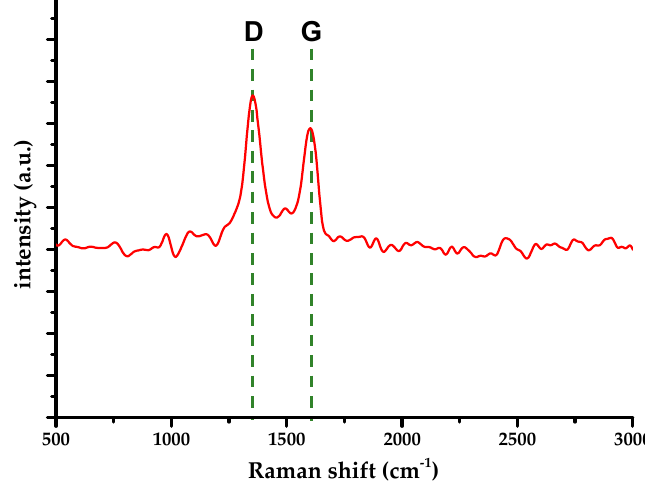
Figure 1. Thermogravimetric analysis of the S-TiO 2 /rGO(5.0%) composite.